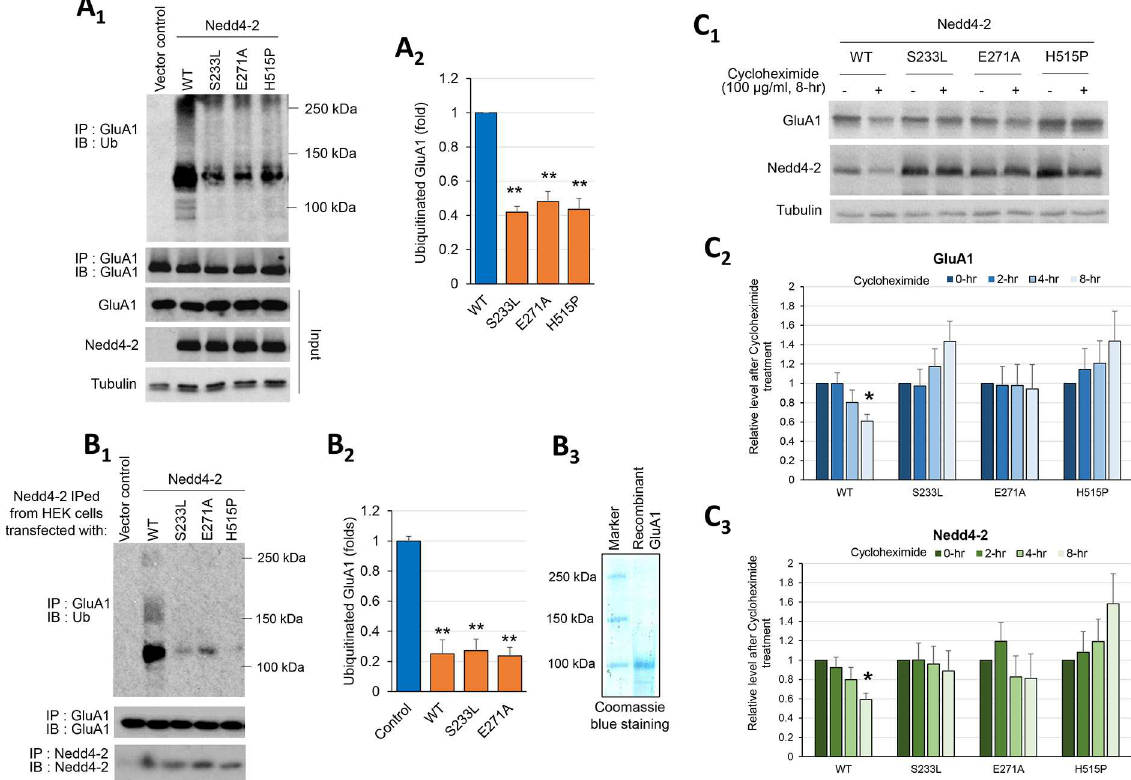
Fig 6. Three epilepsy-associated missense mutations of Nedd4-2 reduce GluA1 ubiquitination. ( A 1 ) Western blots of Ubiquitin (Ub) or GluA1 after immunoprecipitationusing anti-GluA1 antibodyfrom HEK cells transfectedwith GluA1 alongwith HA-tagged WT or mutant Nedd4-2for 48 hours. Quantification of ubiquitinatedGluA1 by the entire area of smear from 100–250kDa is shownon the right ( A 2 ) (n = 4, one-wayANOVA with post-hoc Tukey test). ( B 1 ) Western blots of Ub or GluA1 after immunoprecipitation with anti-GluA1antibodyfollowing in vitro ubiquitination with recombinantGluA1. HA-tagged WT or mutant Nedd4-2s used for in vitro ubiquitination were obtainedfrom HEK cells transfected with one of the Nedd4-2s followedby immunoprecipitation with anti-Nedd4-2 antibody.Quantification of ubiquitinated GluA1 by the entire area of smear ( B 2 ) and Coomassie blue stainingshowingthe purity of recombinantGluA1 ( B 3 ) are shown(n = 4, one-wayANOVA with post-hoc Tukey test). ( C 1 ) Western blots of GluA1 and Nedd4-2 after cycloheximide treatment over an 8-hr time course. HEK cells were transfected with GluA1 and HA-tagged WT or mutant Nedd4- 2s for 48 hours. Cellswere then treated with cycloheximide (100 μ g/ml)to inhibitproteintranslationand followproteindegradation. Representative westernblots after 0- and 8-hr cycloheximidetreatment ( C 1 ) and time coursesof GluA1 ( C 2 ) and Nedd4-2( C 3 ) levels after cycloheximide treatment are shown. Analyseswere performedby comparingGluA1 or Nedd4-2levelat each time point betweencultures receivingdifferent Nedd4-2s (n = 4, one-wayANOVA with post-hocTukey test). For all experiments,data are represented as mean ± SEM with * p < 0.05, ** p <